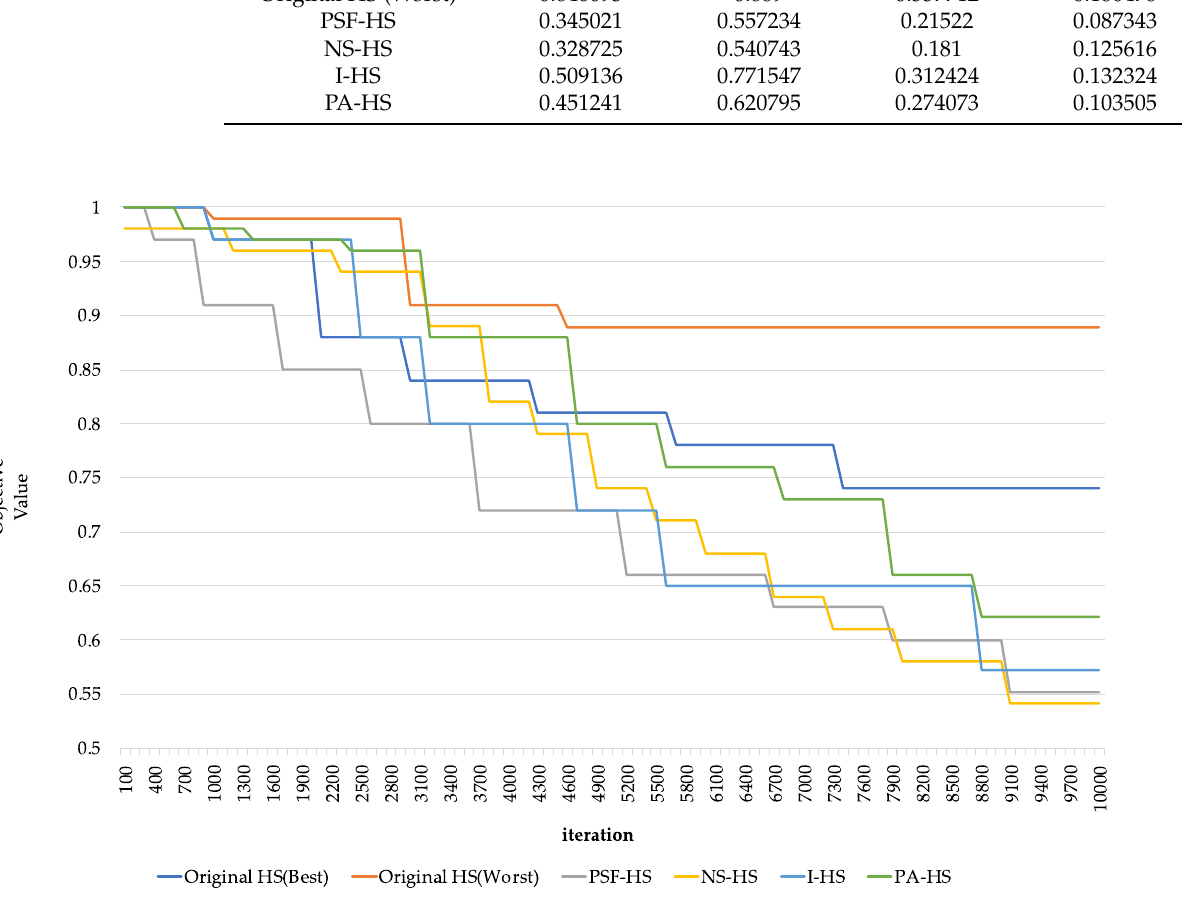
Figure 8. Comparison of improvements in HS and adaptive HS by iteration.